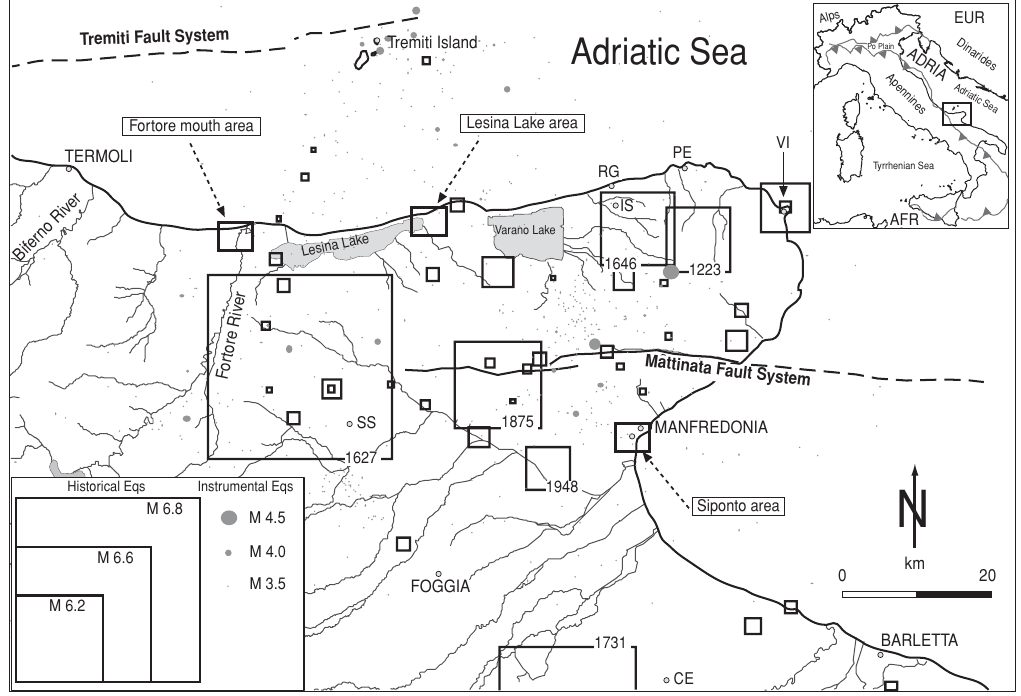
Fig. 2. Historical (CPTI Working Group, 1999) and instrumental (INGV Monthly Bulletin, 1985-2000) seis- micity of the Gargano region. Thick rectangles show the location of the areas investigated in the present study. Abbreviations: RG - Rodi Garganico; IS - Ischitella; PE - Peschici; CE - Cerignola; SS - San Severo; VI - Vieste. Inset in the upper right shows the location of the Gargano region (thick